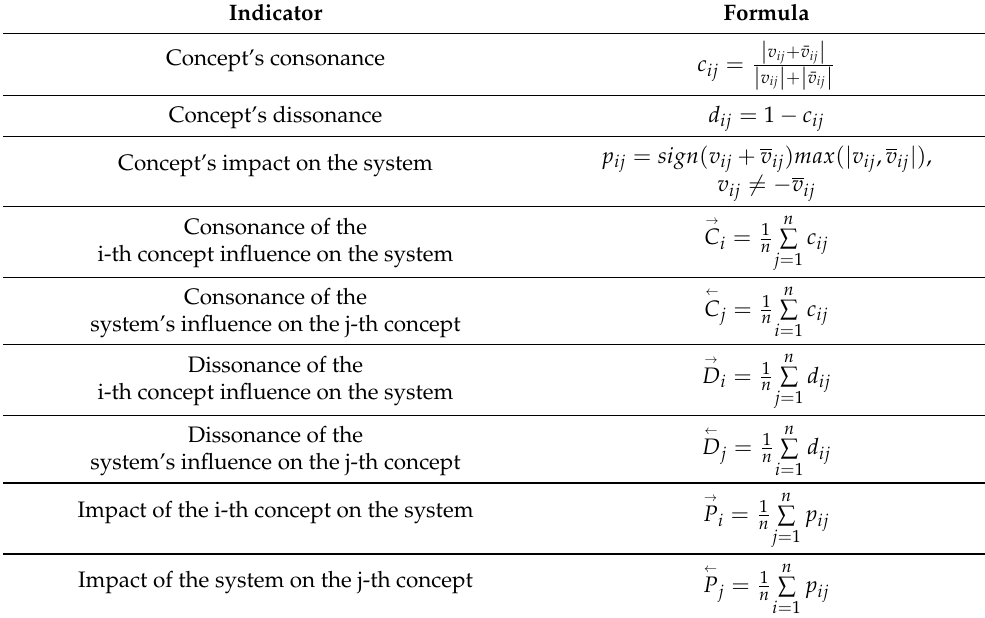
Table 2. System indicators used in